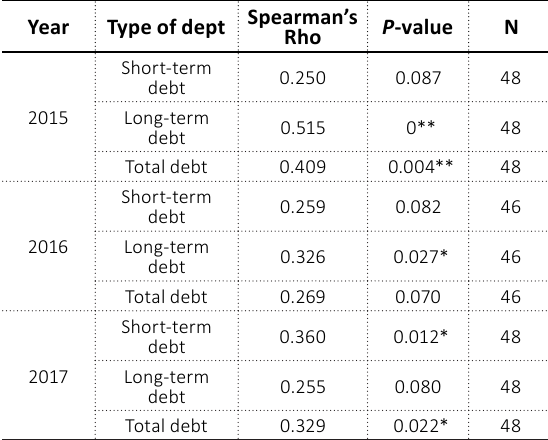
governance index and debt (the case of first